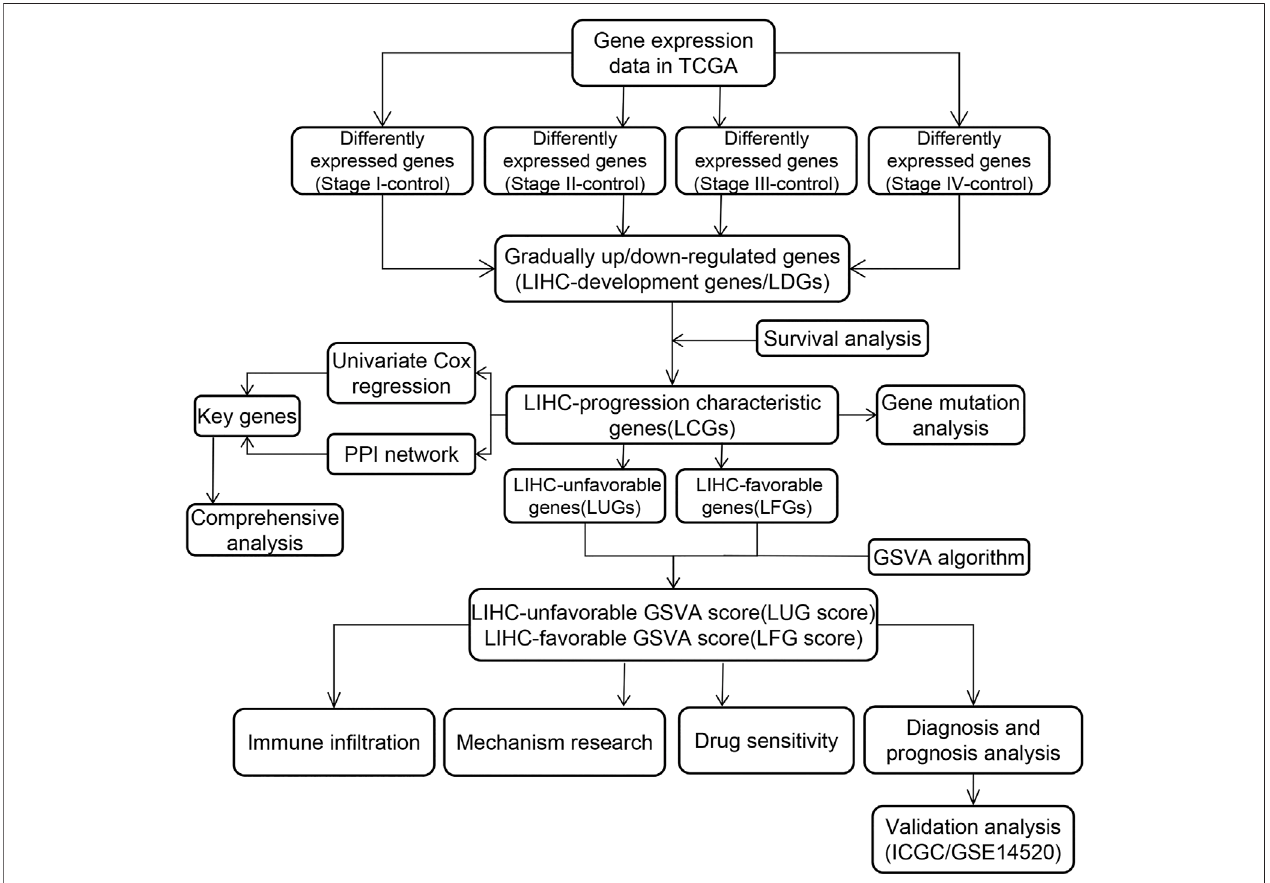
FIGURE 1 | Flow chart of our